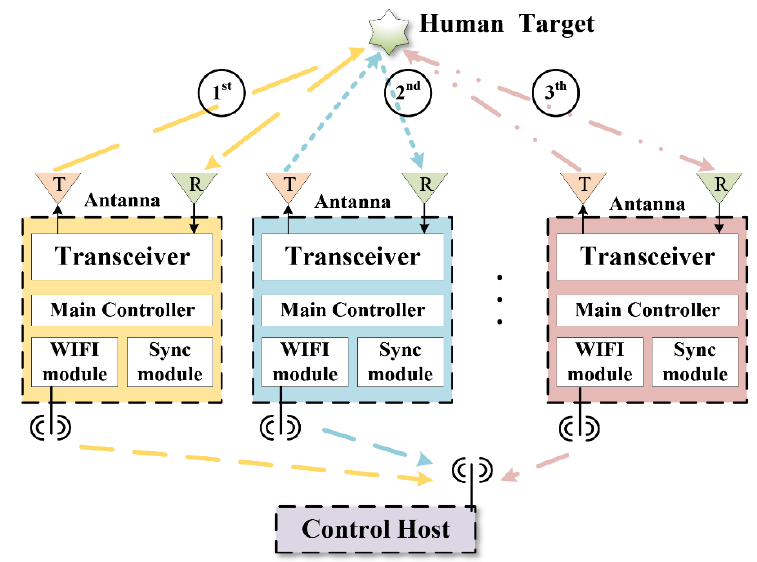
Figure 1. The wireless-netted multi-observation point detection